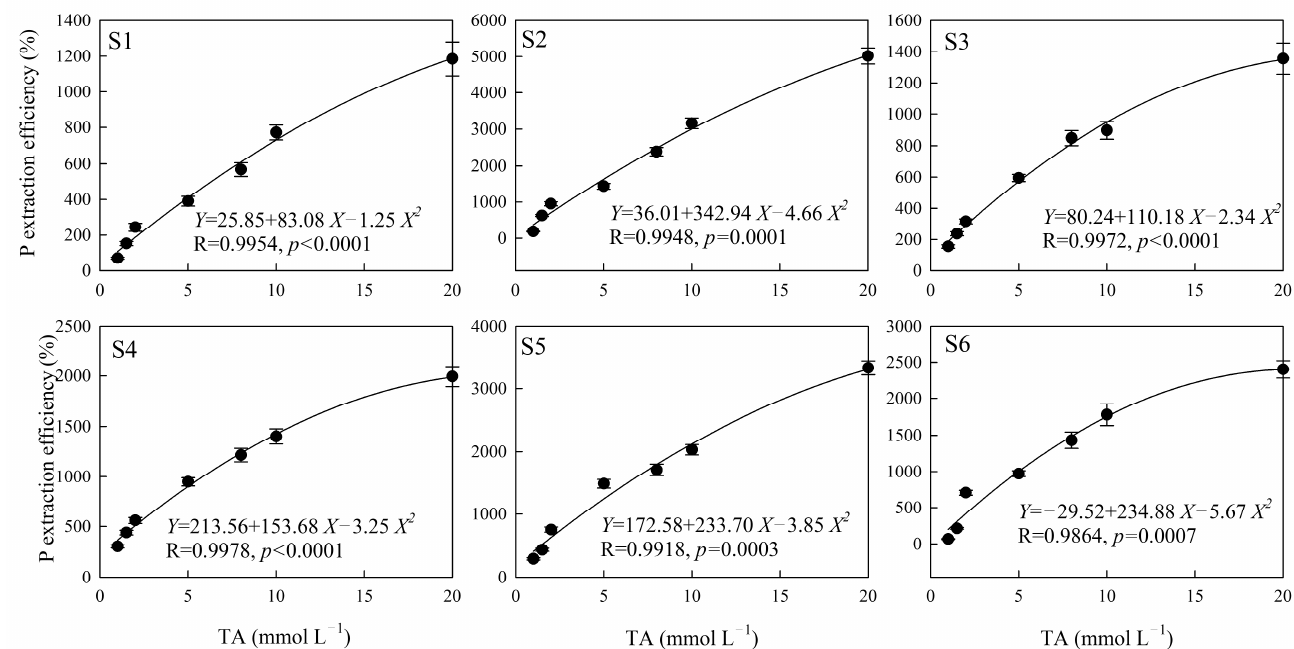
Figure 5. The P extraction efficiency induced by different concentrations of MA. Note: X is the concentration of MA (mmol L − 1 ), Y is the P extraction efficiency of MA (%), R is the correlation coefficient of the fitting equation, and p -value is the significant difference. S1, S2, S3, S4, S5 and S6 are six sampling areas.